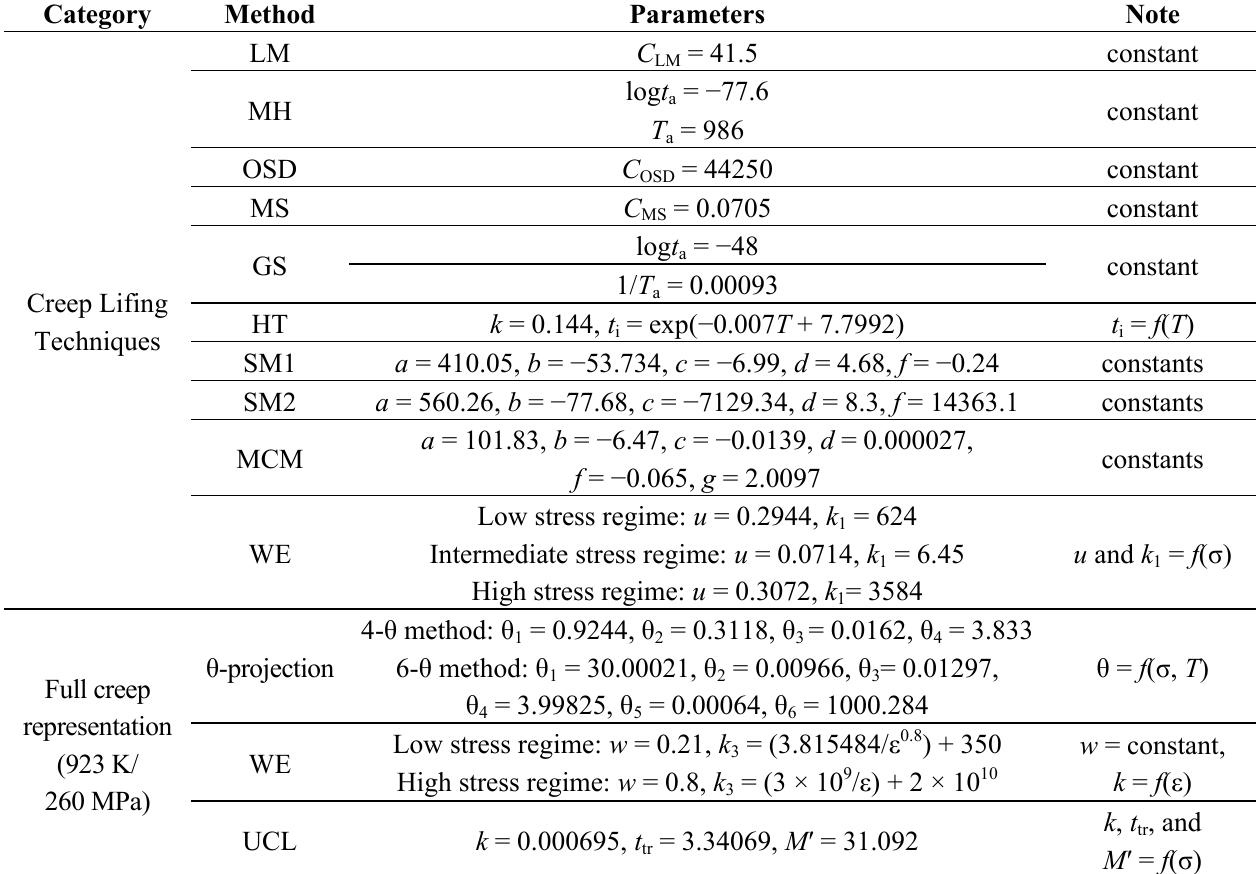
Table 3. Determined constants of creep life